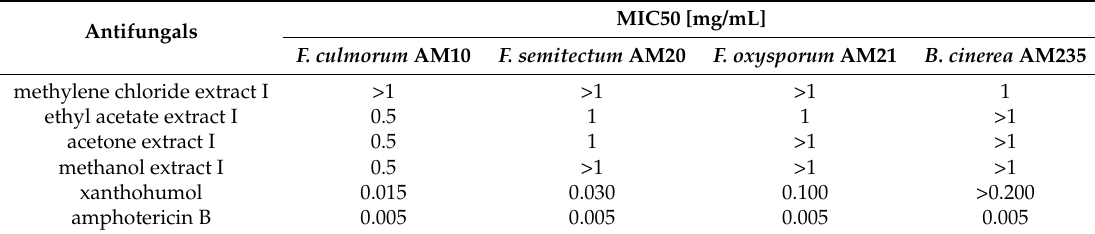
Table 4. The MIC50 of crude extracts against the fungal test